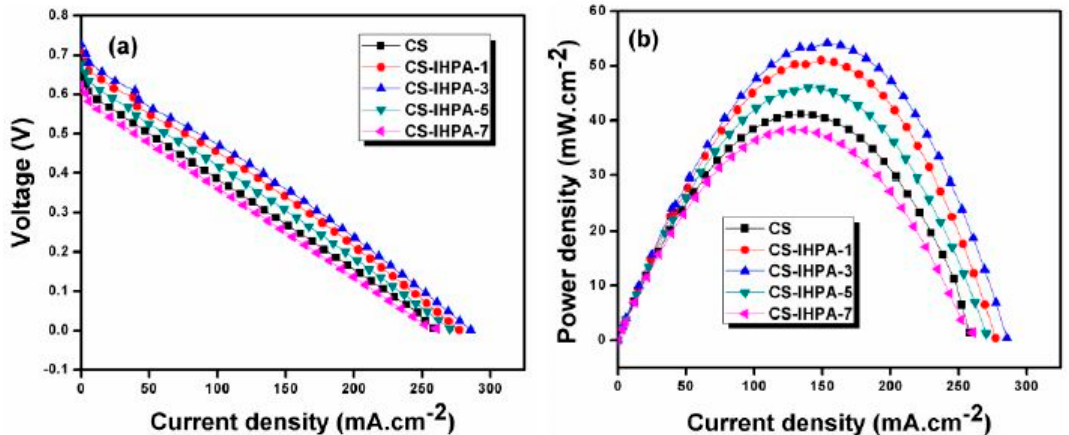
Figure 7. ( a ) Polarization and ( b ) power density curves of CS-IHPA nanocomposite membranes operated in DMFC at 80 °C [60]. Copyright 2018, reproduced with permission from Elsevier